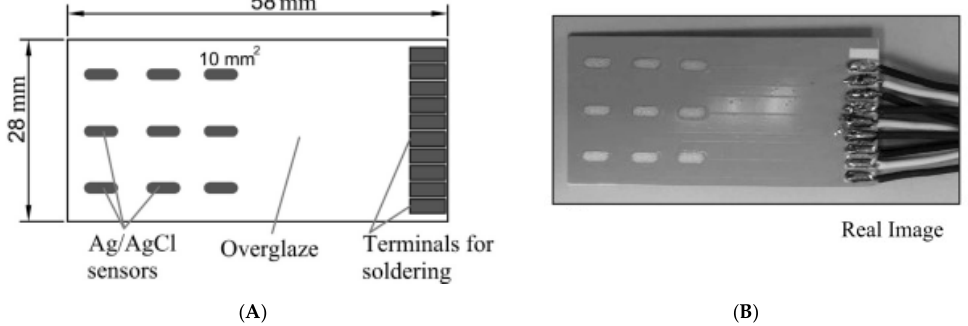
Figure 1. Potentiometric thick-film Cl − sensor arrays: ( A ) substrate dimensions and ( B ) real image [42].